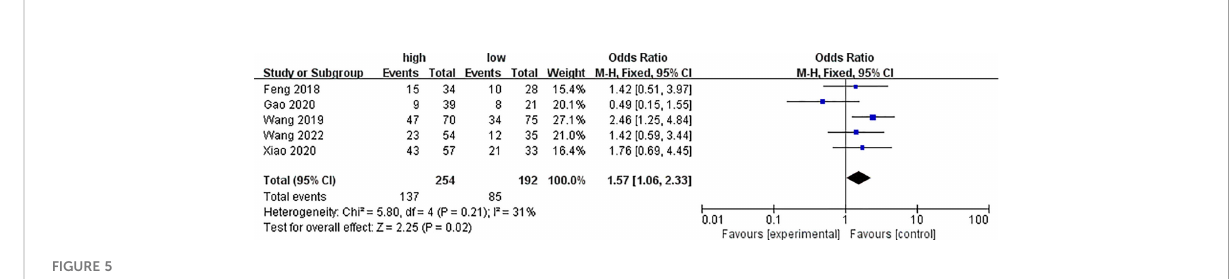
FIGURE 5 Forest plot of meta-analysis of the relationship between PYCR1 expression and cancer lymph node